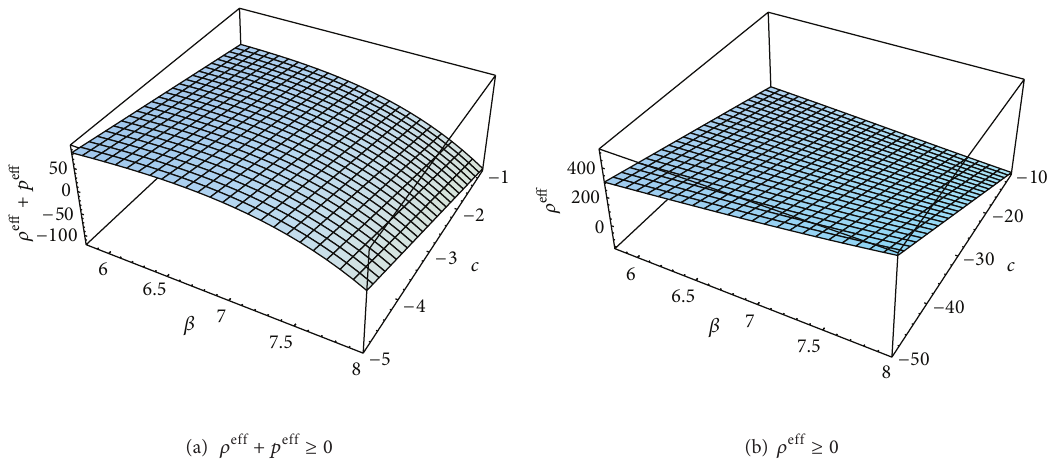
Figure 5: Plots (a) and (b) show WEC versus parameters 𝑐 2 and 𝛽 with 𝑐 3 = 2 , 𝑐 4 = 4 , 𝑐 5 = 3 , and 𝑀 = 2 .